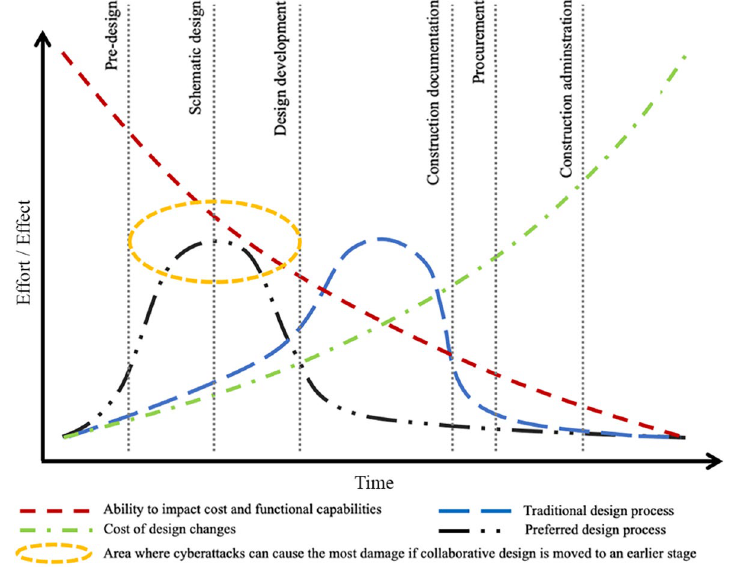
Figure 1. The benefits of BIM in terms of overall design efficiency and quality